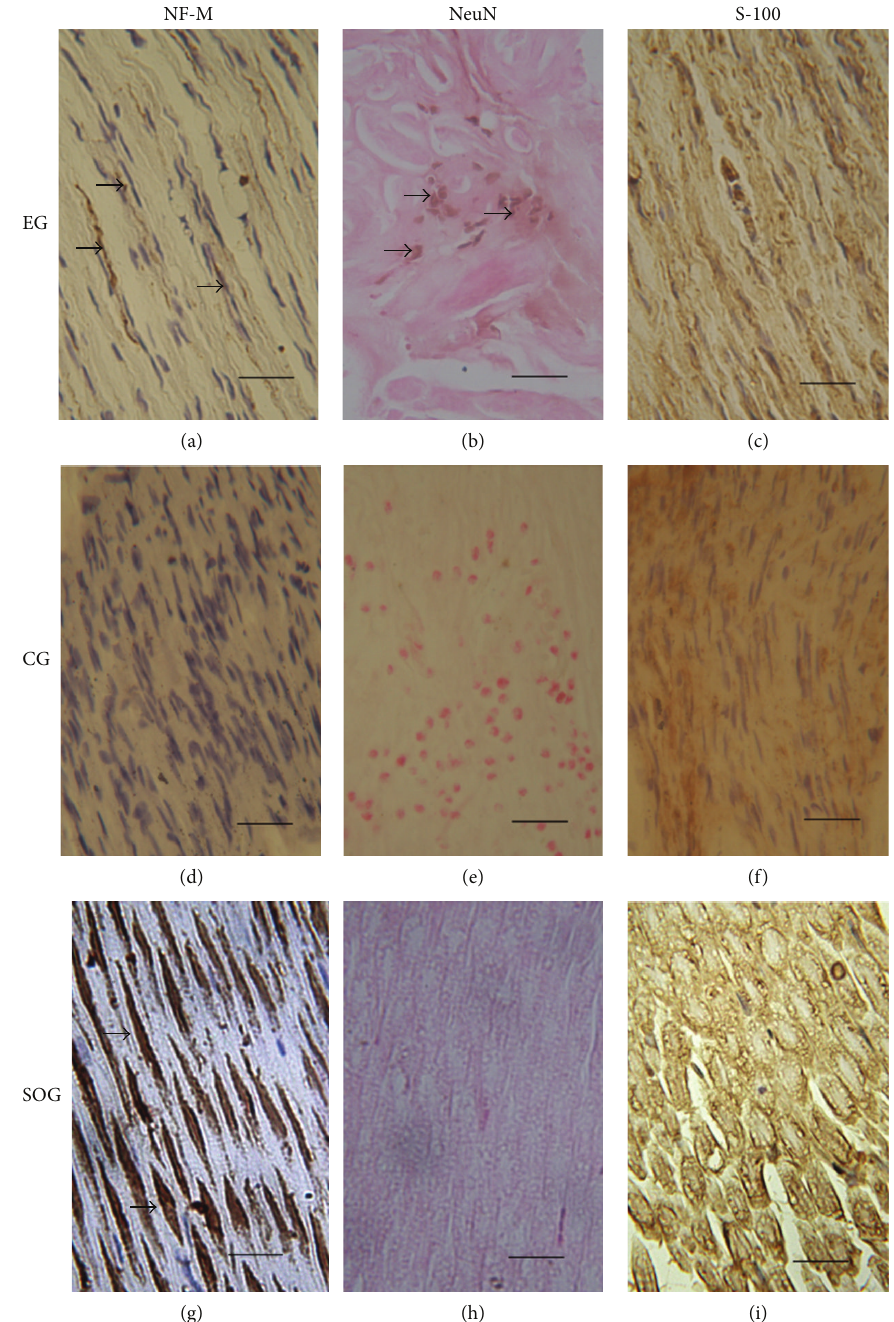
Figure3:Immunohistochemistry.Positiveregions(arrow)ofNF-Mstainingwereobservedintheexperimentalgroupandthesham-operated group ((a), (g)), but not in the control group (d). NeuN staining was only detected in the experimental group ((b), arrow) and not the control and sham-operated groups ((h), (e)). S-100 staining in the sham-operated group was observed in regions of regular morphology (i). S100 staining in the experimental group (c) was higher than in the control group. EG: experimental group; CG: control group; SOG: sham-operated group. Scale bar: 200 𝜇